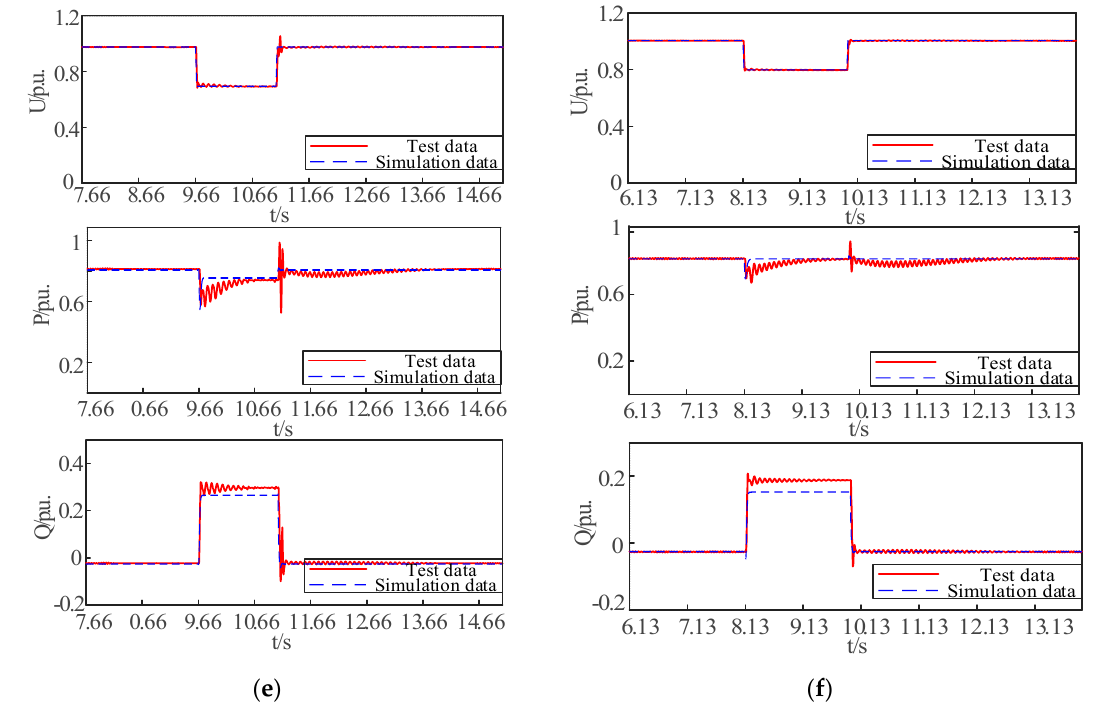
Figure 10. Contrast diagram between simulated data and real test data: ( a ) contrast diagram between simulated data and real test data under operation mode 1; ( b ) contrast diagram between simulated data and real test data under operation mode 2; ( c ) contrast diagram between simulated data and real test data under operation mode 3; ( d ) contrast diagram between simulated data and real test data under operation mode 4; ( e ) contrast diagram between simulated data and real test data under operation mode 5; ( f ) contrast diagram between simulated data and real test data under operation mode 6.